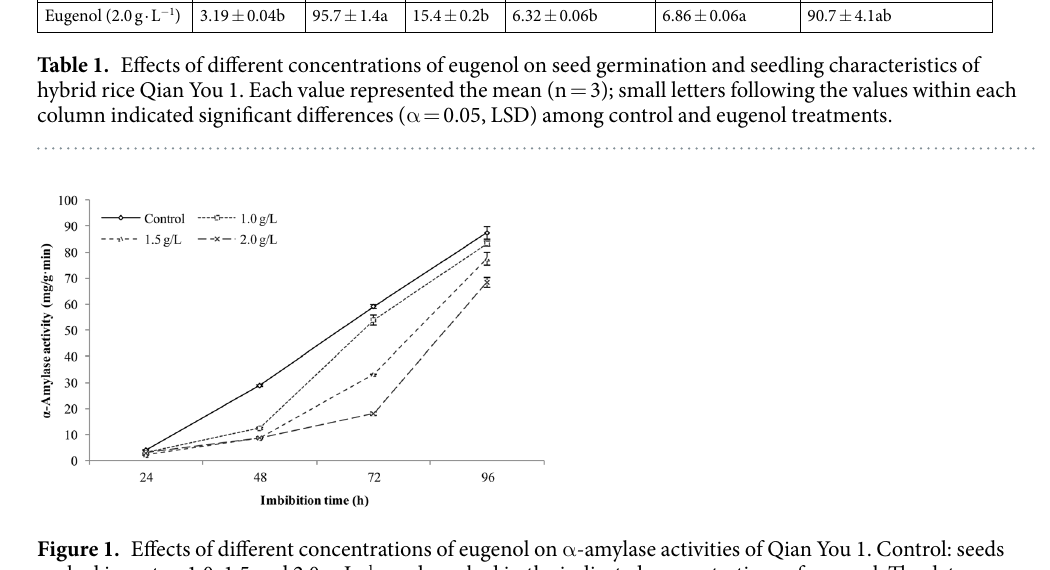
Figure 1. Effects of different concentrations of eugenol on α -amylase activities of Qian You 1. Control: seeds soaked in water; 1.0, 1.5 and 2.0 g · L − 1 : seeds soaked in the indicated concentrations of eugenol. The data were the means of three replications, and the standard deviation was indicated by